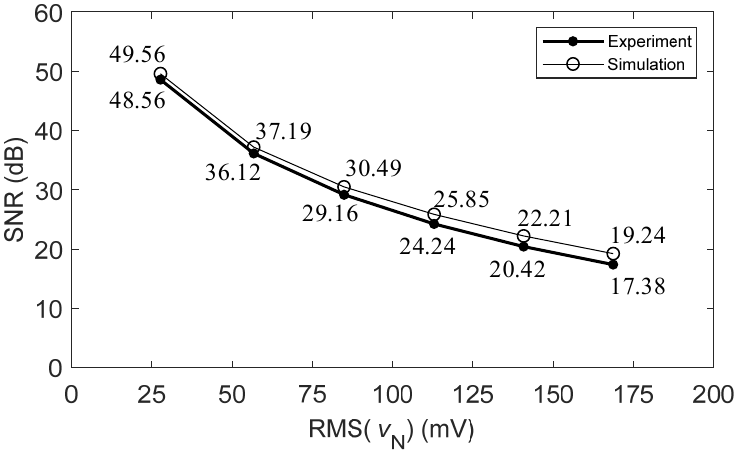
Figure 19. SNR of the proposed event-driven monitoring system with varying input RMS noise level.